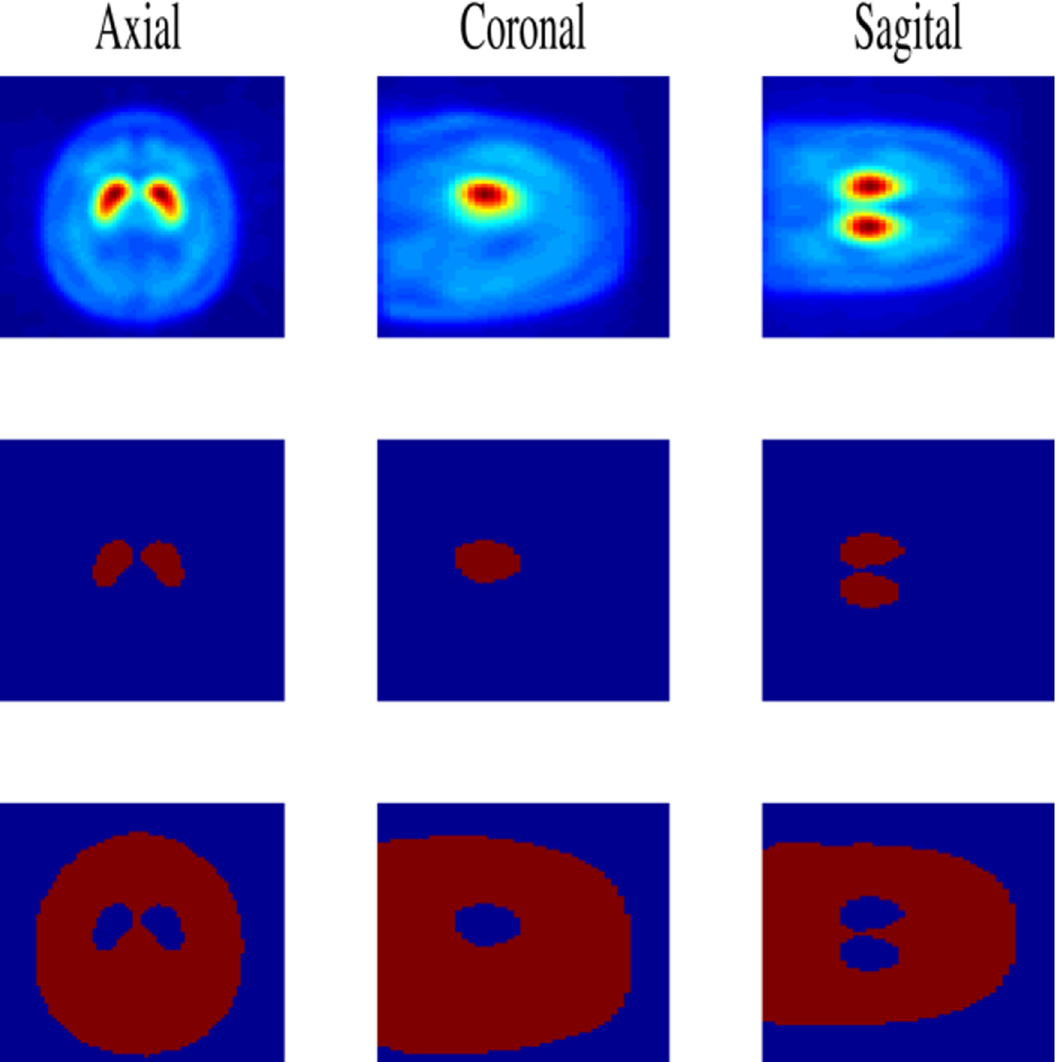
Fig 1. The computed template and the different masks used in the intensity normalization process. First row: template image generated by averaging the NCs. Second row: the striatum mask applied in FGMM approach. Third row: the non-specific mask applied in MSE approach.